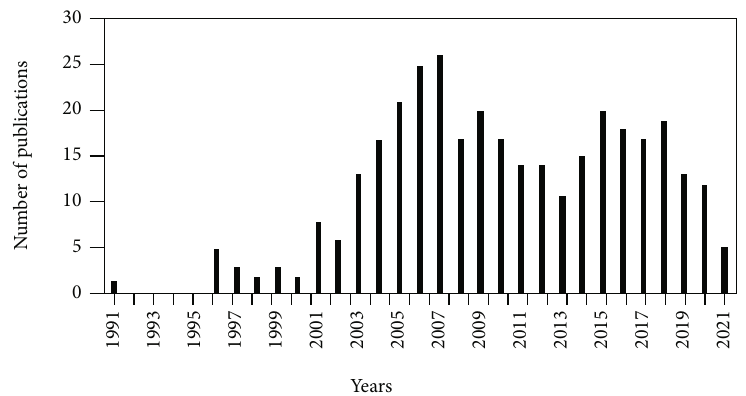
Figure 5: Evolution of the number of published research articles and reviews containing “ microwave ” and “ polymerization ” in their title (from Web of